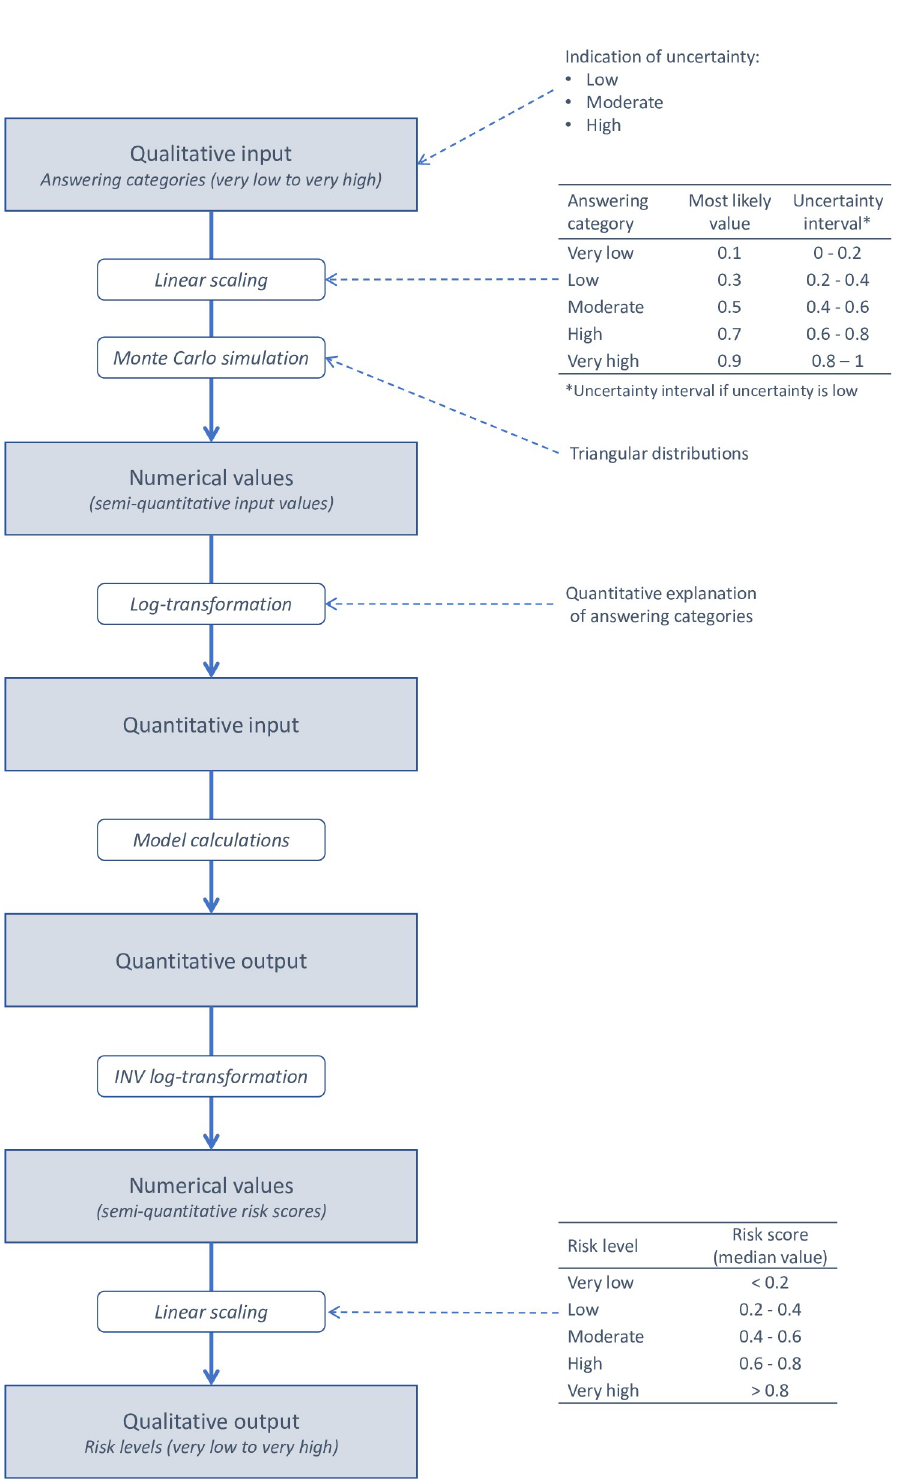
Fig 2. Schematic overview of how qualitative input into MINTRISK is transformed into quantitative input that can be used for the model calculations and how results are subsequently transformed back into qualitative risk